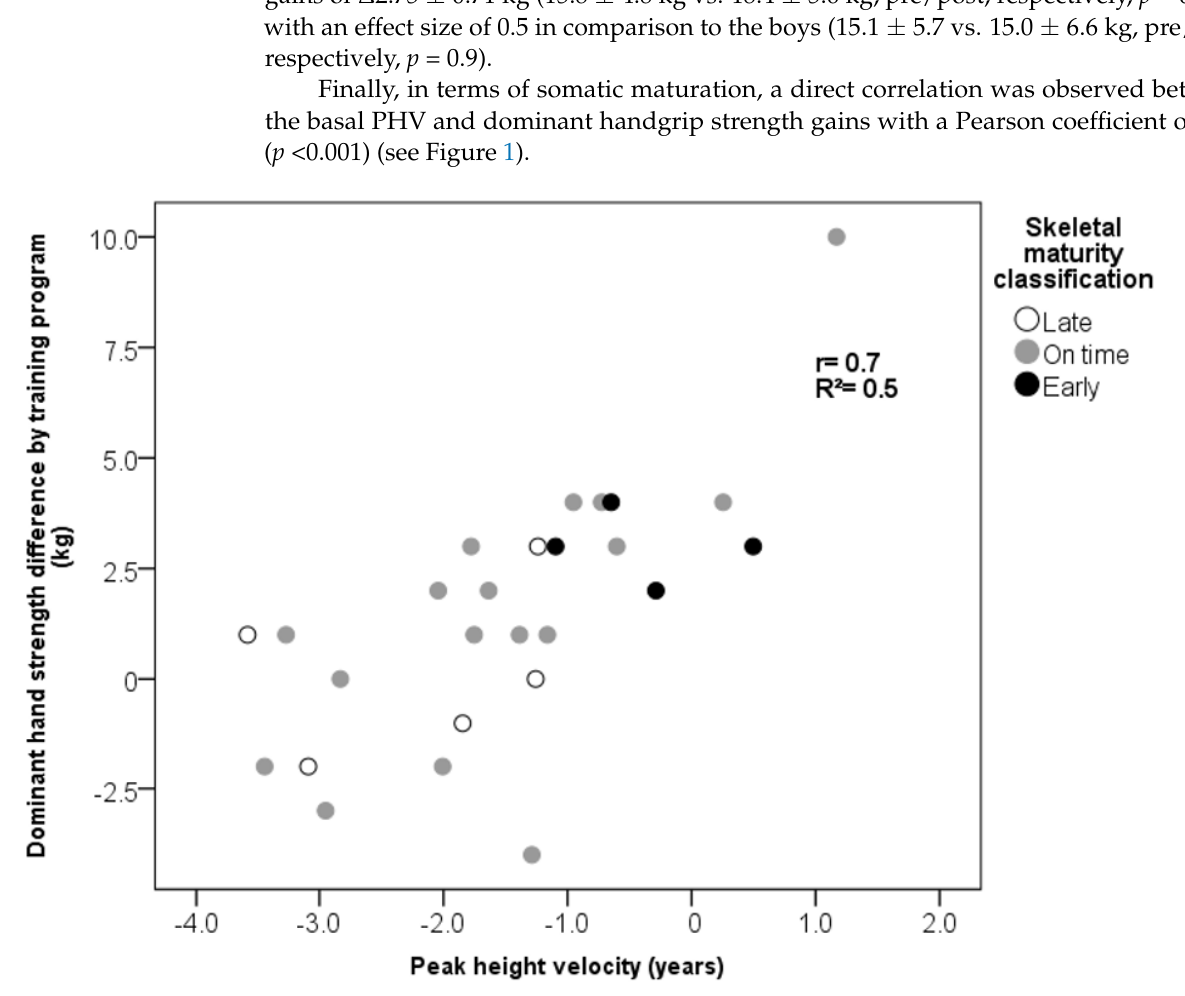
Figure 1. The correlation between the basal PHV and dominant hand strength observed after the training